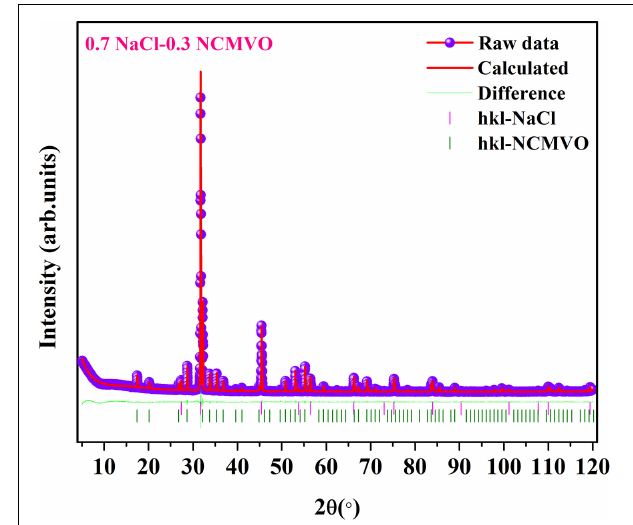
FIGURE 3 | Rietveld refinement analysis of 0.3NCMVO-0.7 NaCl composite ceramic using the TOPAS 4.2